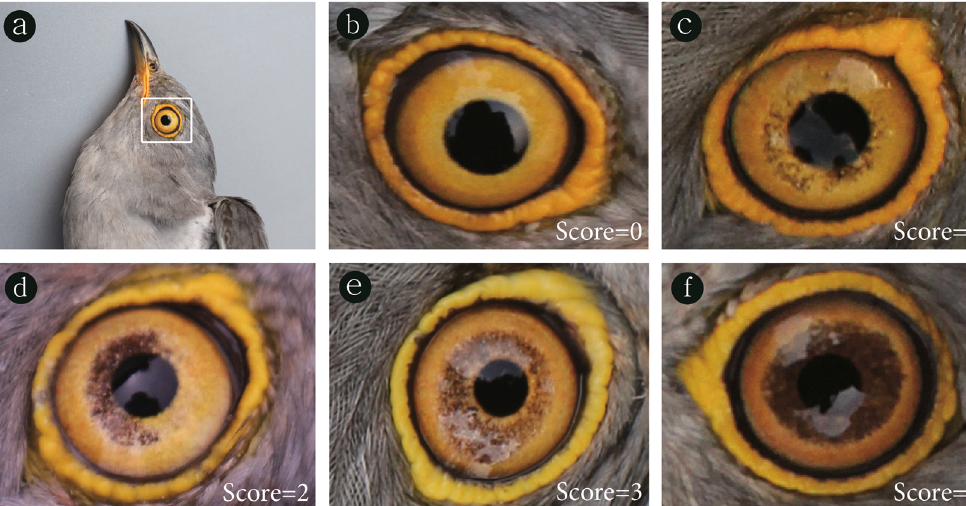
Figure 6. A reference standard used in this study for the amount of iris flecking in the common cuckoo ( a ). A score of 0 ( b ) was given for the iris that is clear without any flecks. In contrast, a score of 4 ( f ) was assigned when the pupil was completely surrounded by the thick band of dark flecks. Other scores of 1 ( c ), 2 ( d ), and 3 ( e ) were given according to the relative amount of